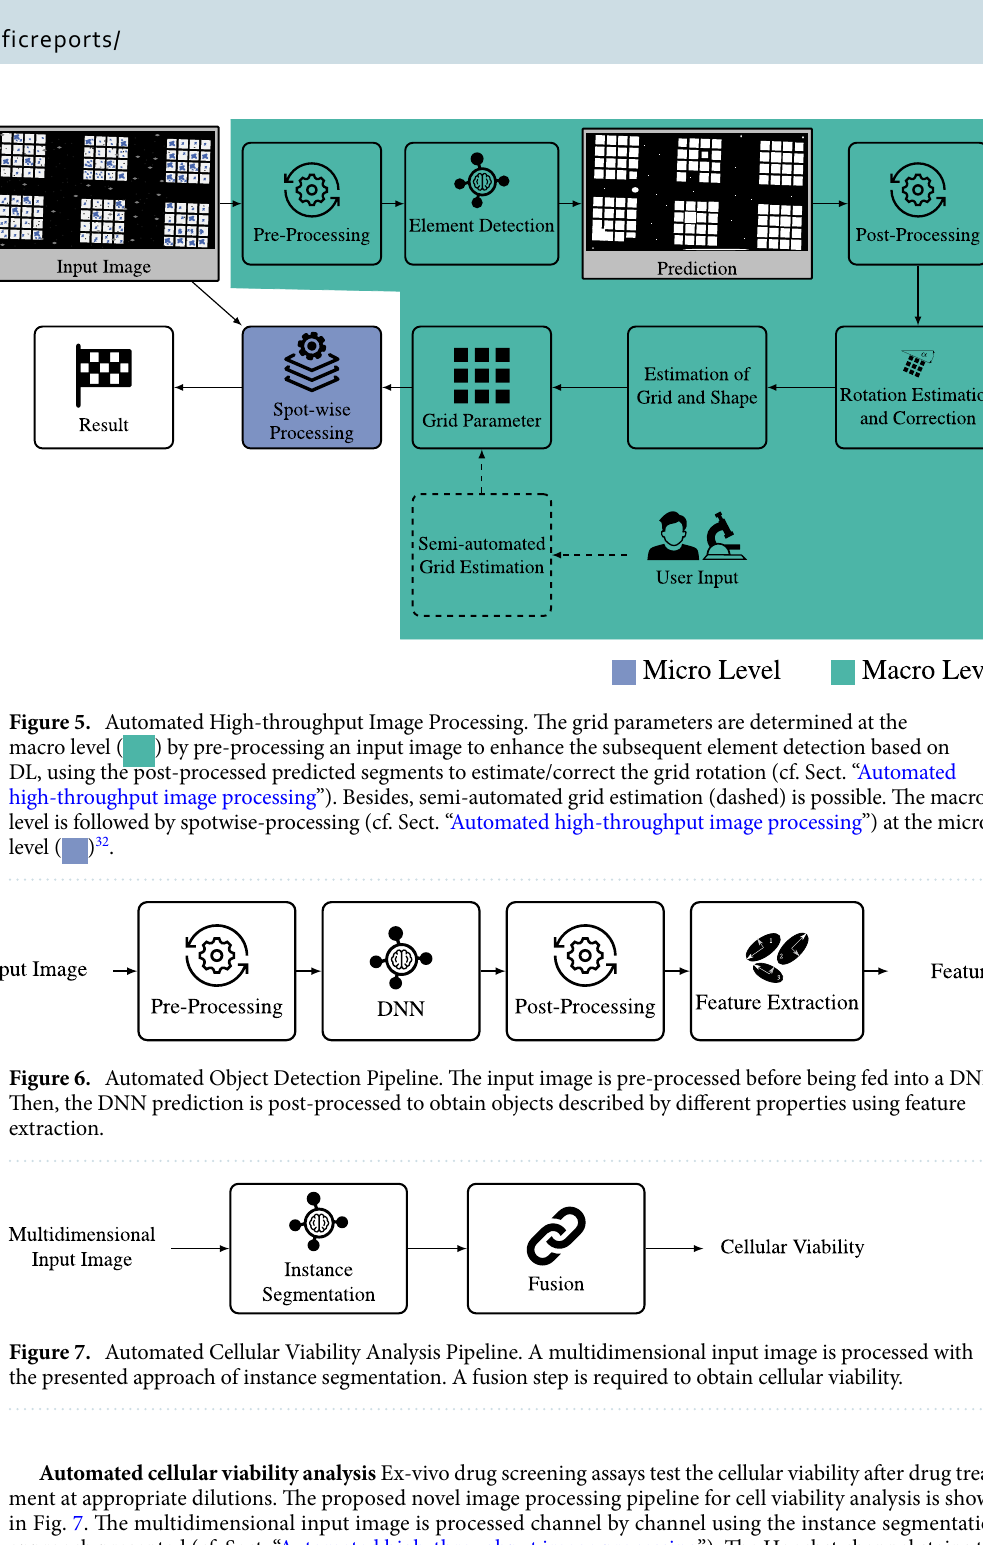
in Fig. 7. The multidimensional input image is processed channel by channel using the instance segmentation approach presented (cf. Sect. “Automated high-throughput image processing”). The Hoechst channel stains the nucleus of all cells, dead or alive, giving the total number of cells. Calcein indicates only living cells, and PI stains the nucleus of cells containing ruptured cell membrane (dead cells). However, some cells appear to stain faintly for Calcein, while at the same time being already positive for PI. In a fusion step, the information is merged. Using the k-nearest-neighbor algorithm, matching instances between the different staining channels are obtained. Then, cellular viability can be calculated by comparing the total number of cells with the instances that meet the specified criteria (Hoechst/Calcein positive, but PI negative). Colorimetric analysis In many high-throughput experiments, colorimetric analysis of scanner images can converted into each other via a calibration measurement. Next, an abstract transformation function is used to